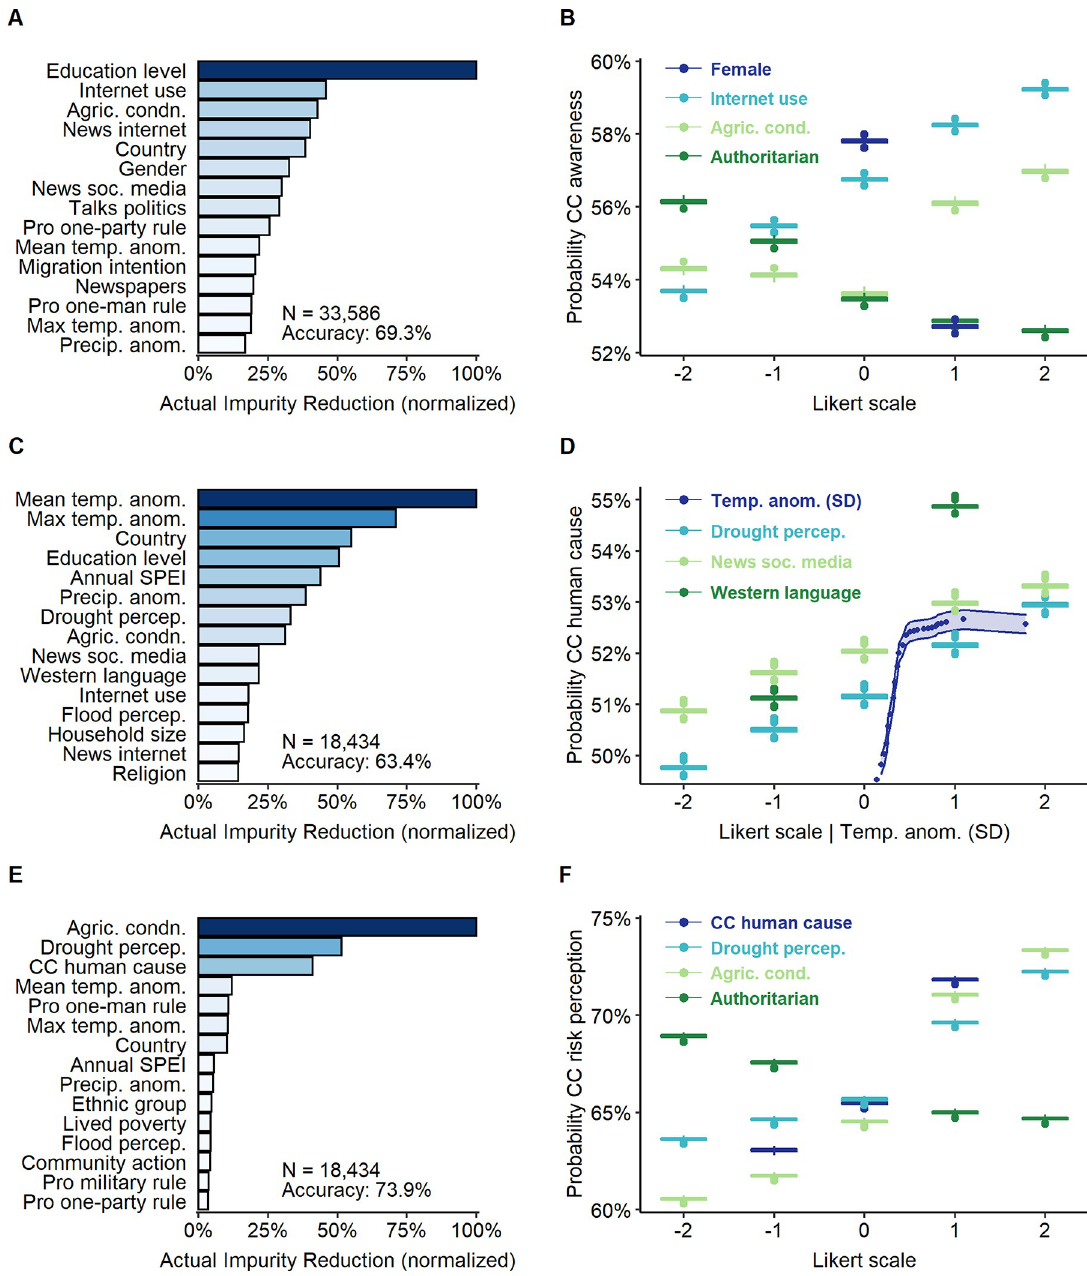
Fig 1. Key predictors for climate change awareness, anthropogenic climate change, and climate change-related risk perception. Top 15 predictors of climate change awareness (A) (69.4% prediction accuracy), human causation of climate change (C) (63.4% prediction accuracy), and risk perception (E) (73.9% prediction accuracy). (B) Partial dependence plot (PDP) of gender ( female ), access to online news ( news tech ), being favourable to one-party rule ( authoritarian ), and perceived agricultural conditions ( agric . cond .) about climate change awareness. (D) PDP of mean temperature anomalies ( temp . anom .), precipitation anomalies ( precip . anom .), trust in institutions ( trust institutions), and access to online news ( news tech ) over belief in human causation of climate change. (F) PDP of belief in human causation of CC ( CC human cause ), perceived severity of drought ( drought percep .), perceived agricultural conditions ( agric . cond .) and being favourable to one-man rule ( authoritarian ) over climate change risk perception.